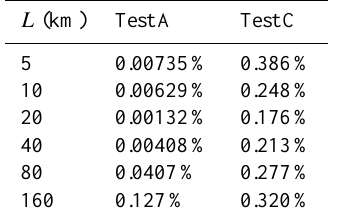
al. (2012) solutions for ISMIP-HOM tests A and